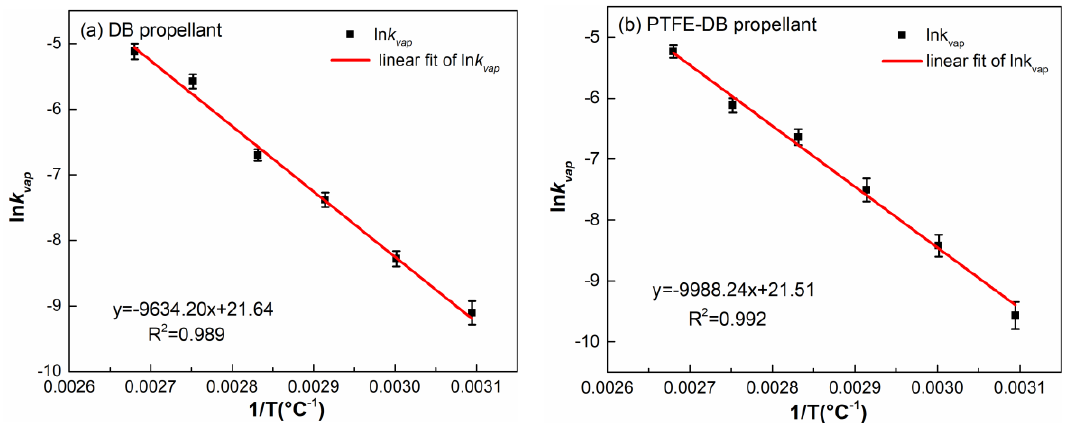
Figure 6. Arrhenius plots of weight loss rate of DB propellant ( a ) and PTFE-DB propellant ( b ).